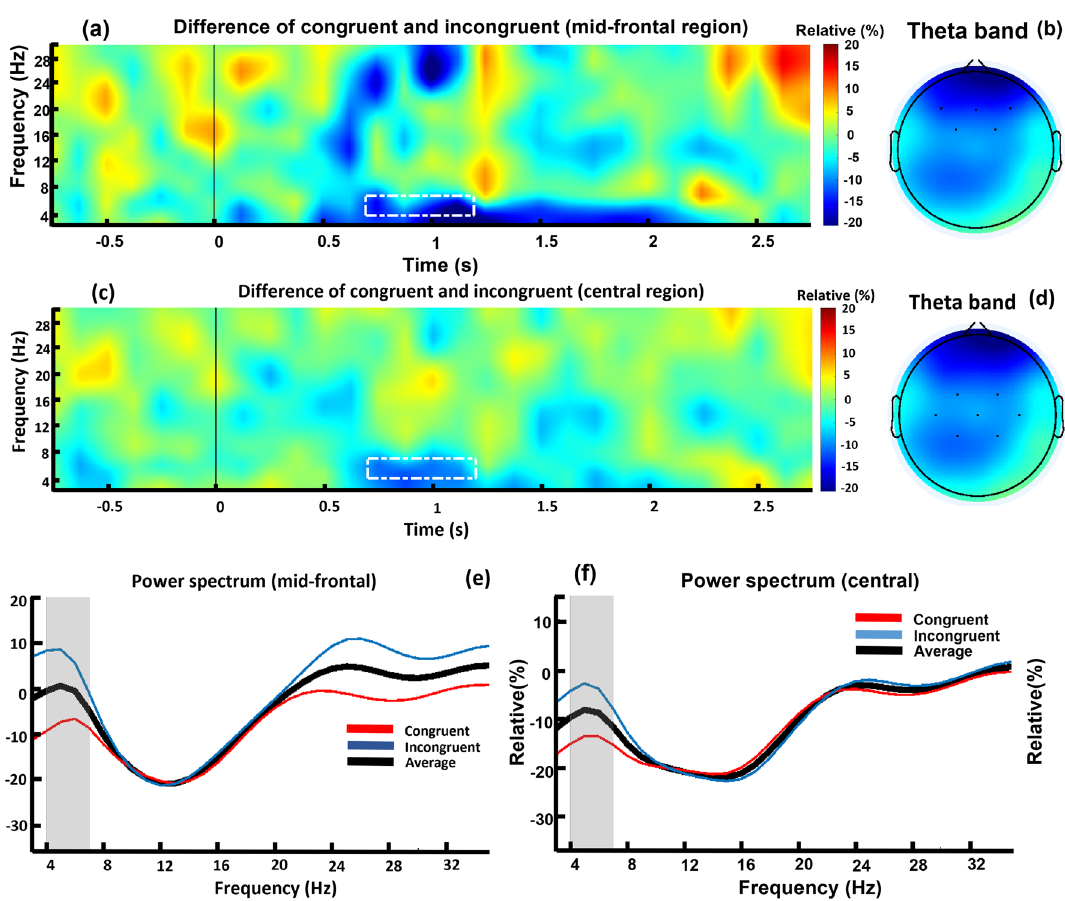
Figure 3. Time–frequency differences (congruent-incongruent), topo-maps (of theta band), and power spectrums. Hot colors show positive relative power and cold colors show negative relative power. Panels ( a ) and ( c ) show the subtracted TF of incongruent condition from congruent condition (congruent-incongruent). The white rectangle shows the region of theta frequency (4 to 7 Hz) and time (700 to 1200 ms), where the difference is maximum. The statistics, topo-maps, and power spectrum of this figure are all focused on this region. Panel ( a ) shows the TF difference in mid-frontal region and panel ( c ) shows the TF difference in central region. Panels ( b ) and ( d ) show topo-maps for mid-frontal and central regions respectively. They show brain activity averaged on the theta frequency and 700 to 1200 ms (the area of white rectangular). Panels ( e ) and ( f ) show the power spectrum activity of mid-frontal and central regions respectively. They show power spectrum of all frequencies averaged over time. The gray regions in both panels indicate the theta band, and there is significant difference between congruent and incongruent conditions both in mid-frontal (p = 0.03, effect size = − 0.54) and central (p = 0.01, effect size = − 0.69) regions. In both panels, the yellow curve shows the power spectrum of congruent, the red curve shows the power spectrum of incongruent, and the black curve shows the average power spectrum of congruent and incongruent